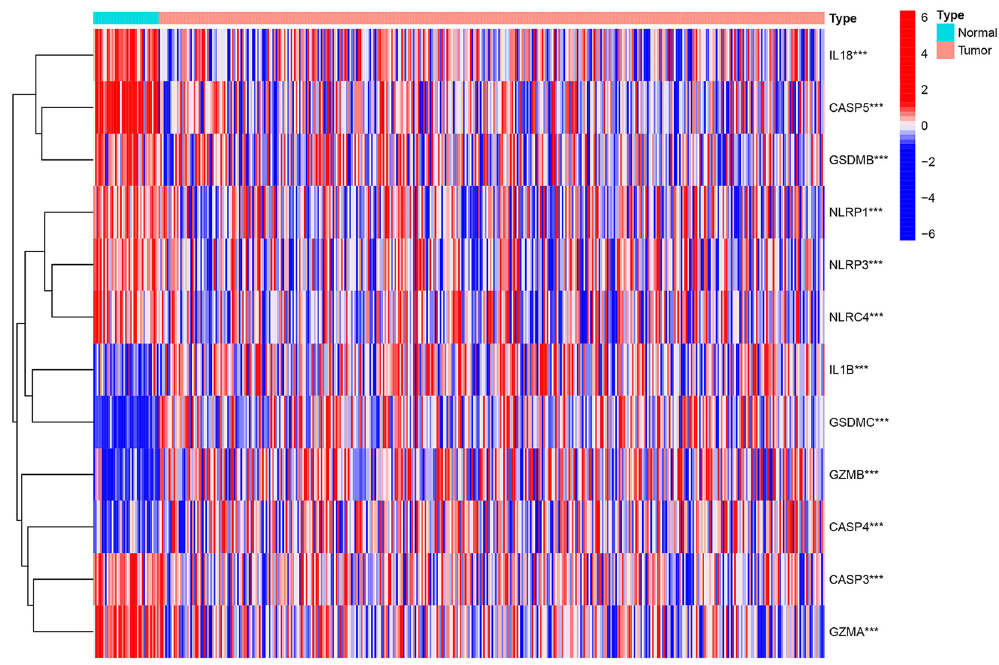
Figure 1. The expression of these differentiated-expressed pyroptosis-related